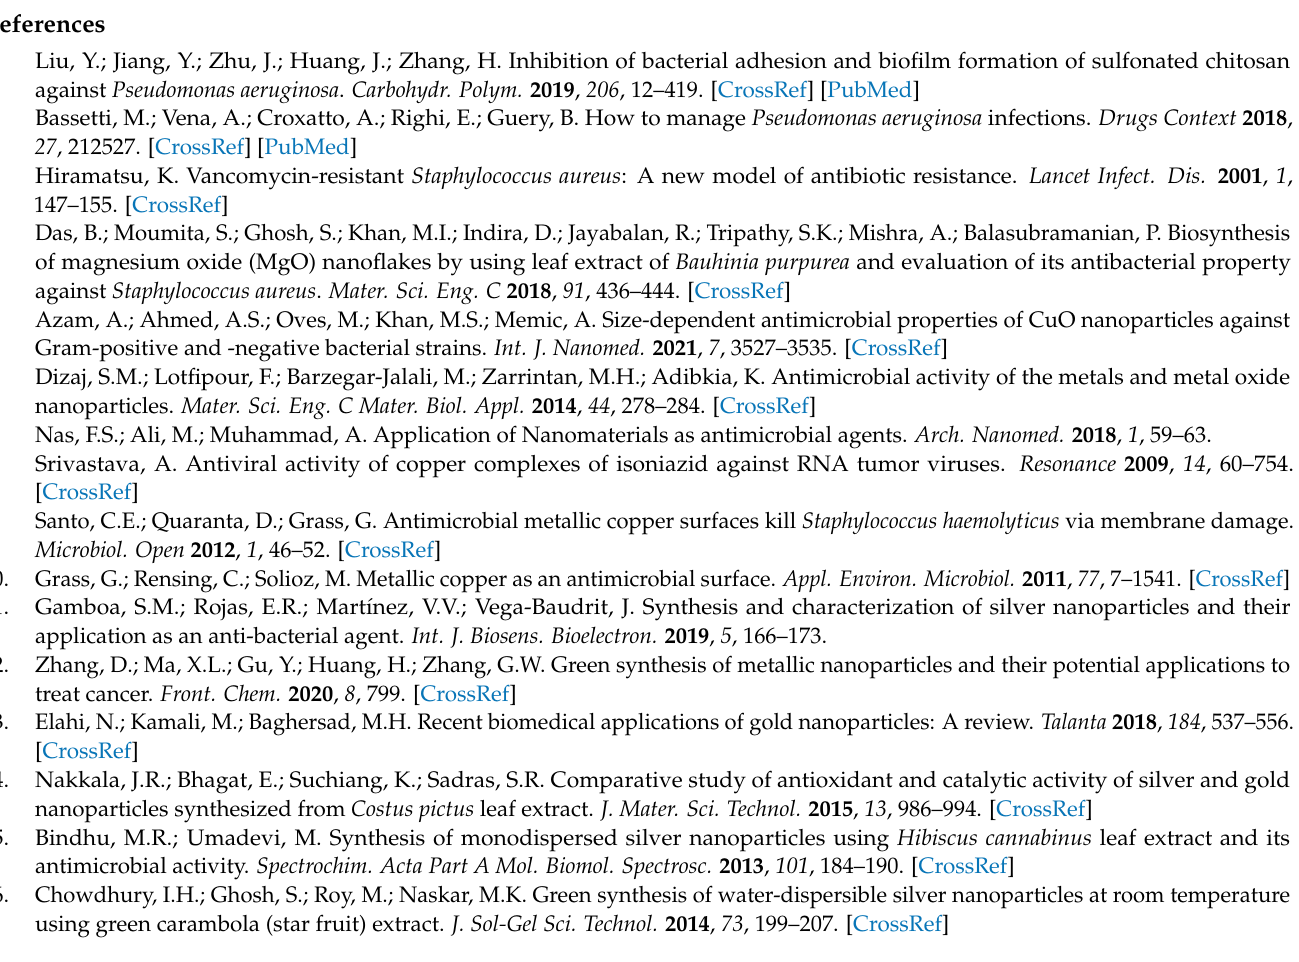
Figure S4: Inhibition of bacterial growth by cup plate experiment in the presence of OLE for all bacteria strains; Table S1: Assessment of the antimicrobial effect of CHT -CuO nanocomposites on gram positive and gram negative bacteria based on turbidity visualization of the culture and bacterial count on solid Agar plate. Values in brackets represent bacteria counts or colony forming units (CFU × 10 6 /mL) after 24 h culture. Positive control presents culture liquid without bacterial inhibitor substance, and negative control is the culture without bacteria. ‘–’ infers complete growth inhibition where ‘+’ indicate bacteria